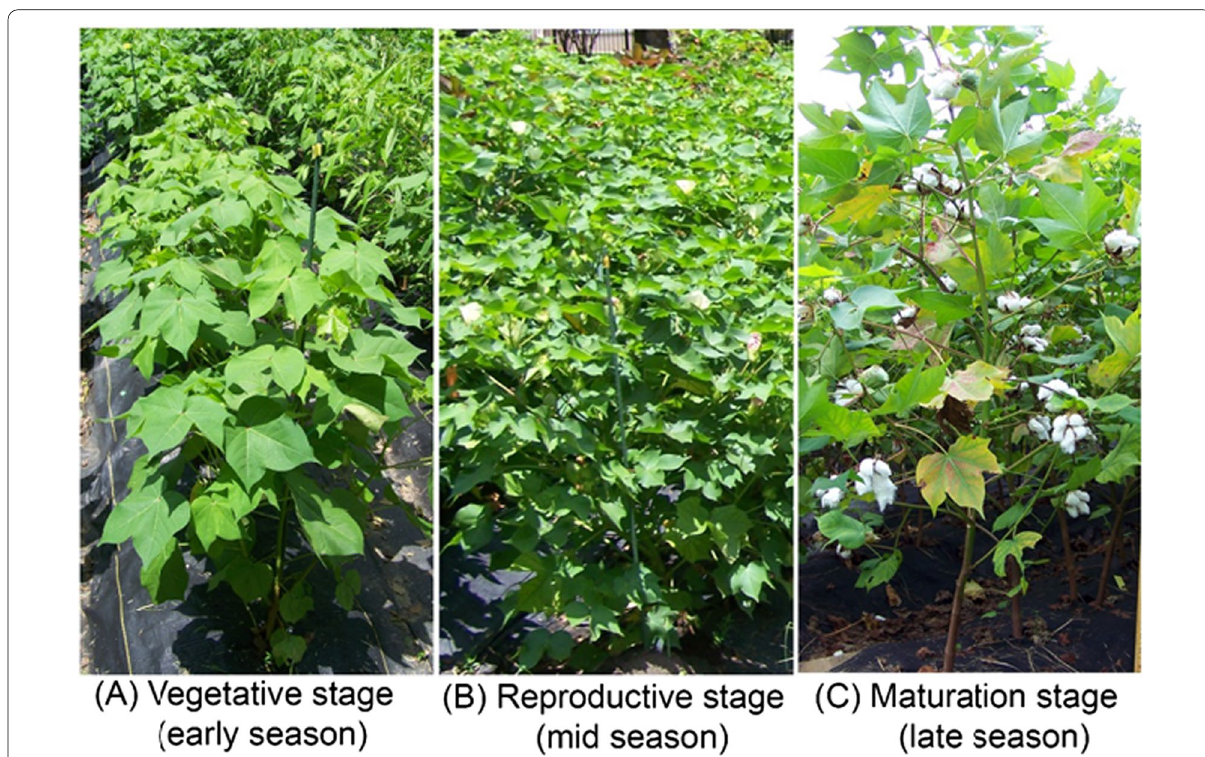
Fig. 1 Seasonal development of cotton. Cotton developmental stages were classified according to the three different seasons described in Oosterhuis and Jernstedt (1999). Green garden stakes (90 cm) were used as a scale marker